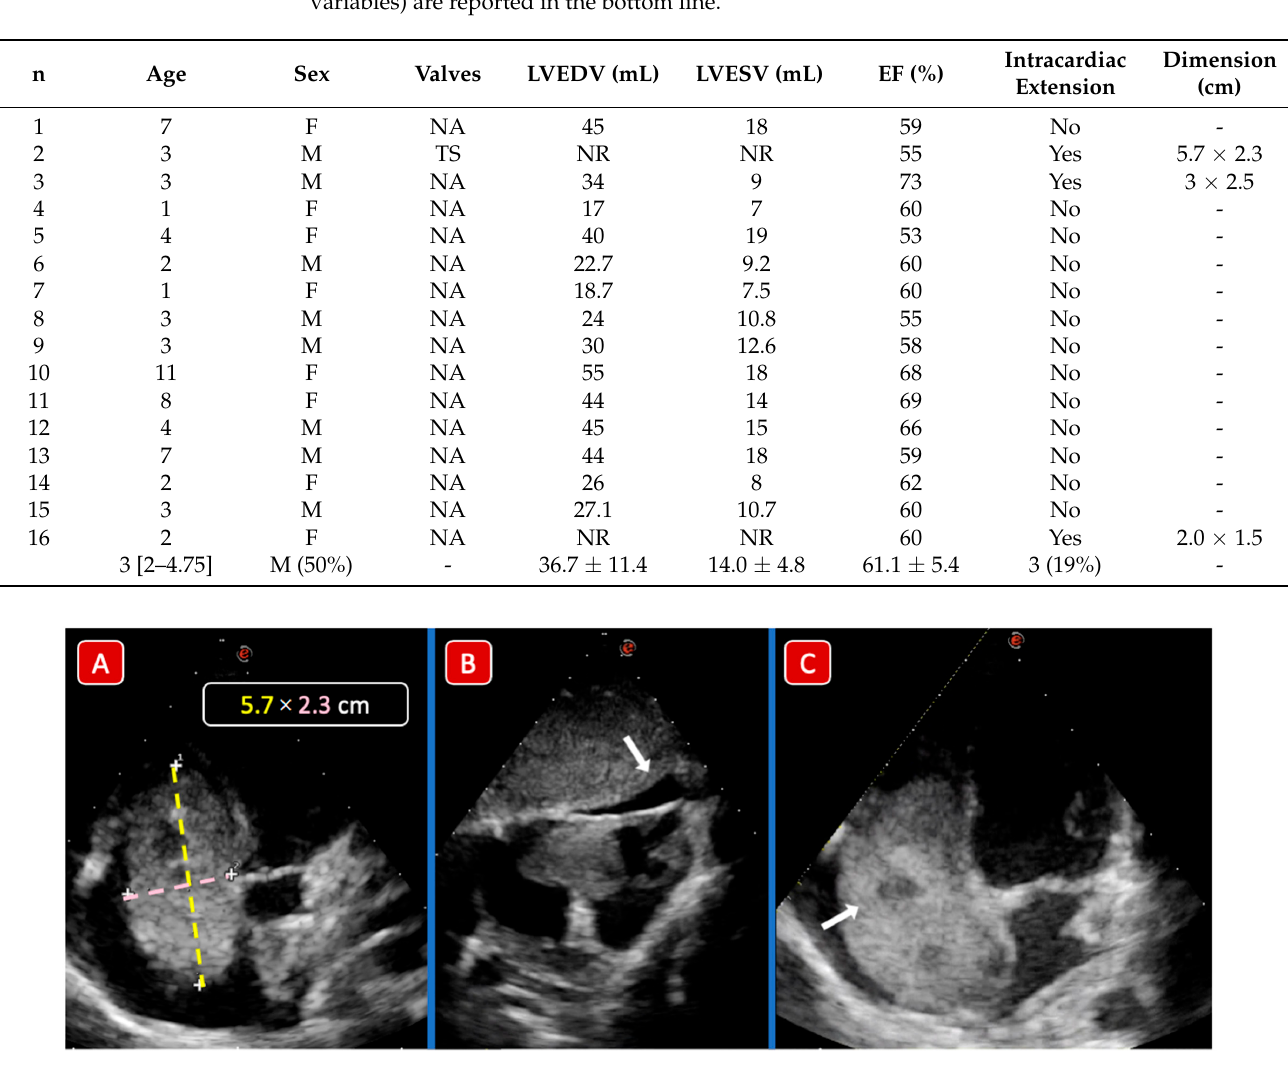
Figure 1. Case 1 echocardiographic images. Apical 4 chambers view: a gross ovoid mass measuring 5.7 × 2.3 cm can be visualized in the RA. The mass engages the TV plane protruding into the right ventricle (Panel ( A )). Subcostal view (Panel ( B )) confirms the pres-ence of a very mobile mass and shows a mild-moderate associated pericardial effusion (white arrow). The mass has an irregular and inhomogeneous structure with ultrasound images consistent with areas of vacuolization and/or tis- sue necrosis (white arrow) (Panel ( C )).